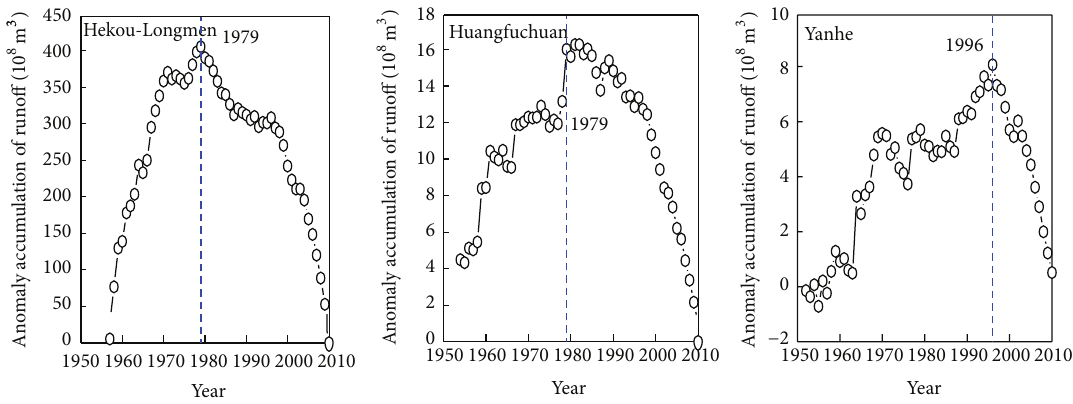
Figure 3: Accumulative anomaly curve of runoff in the Hekou-Longmen region, Huangfuchuan, and Yanhe.